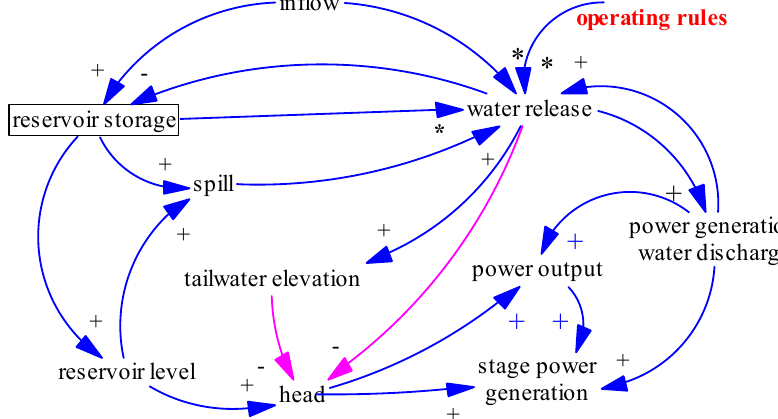
Figure 3. Causal loop diagram for hydropower reservoir operation.